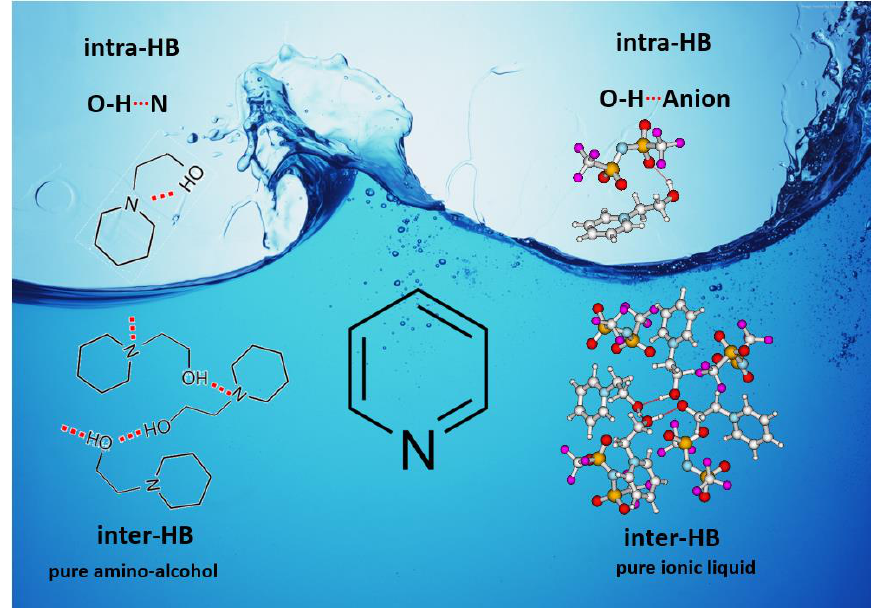
Figure 2. The inter-molecular ( HB inter ) and intra-molecular ( HB intra ) hydrogen bonding in MLs and corresponding ILs.